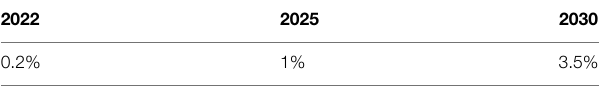
TABLE 4 | Share of advanced biofuel targets as a percentage of total energy use according to RED